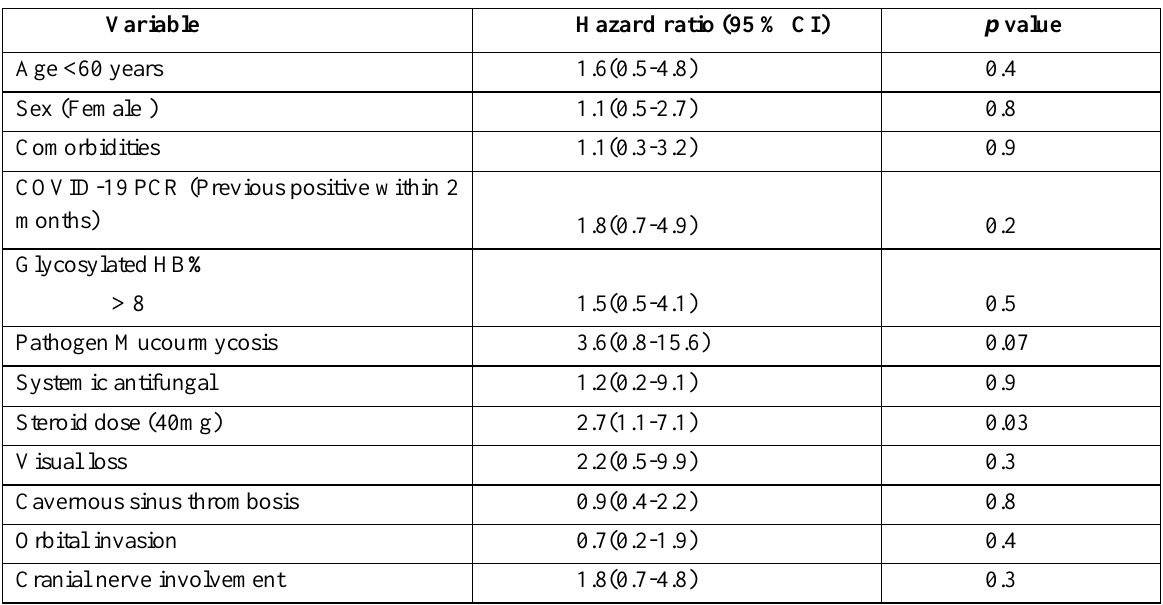
Figure 1. A 72 years old Male patient with uncontrolled diabetes mellitus after 3 weeks of COVID-19 infection (A) intraoral photograph showing massive palatal necrosis (B) multiple coronal cuts of a CT scan of paranasal sinuses showing opacification of ethmoid, frontal and maxillary sinuses (C) multiple coronal cuts of an MRI with contrast on paranasal sinuses showing mixed intensities of maxillary and ethmoid sinuses (D) intraoperative view after total maxillectomy (E) resection specimen showing evident necrosis of the